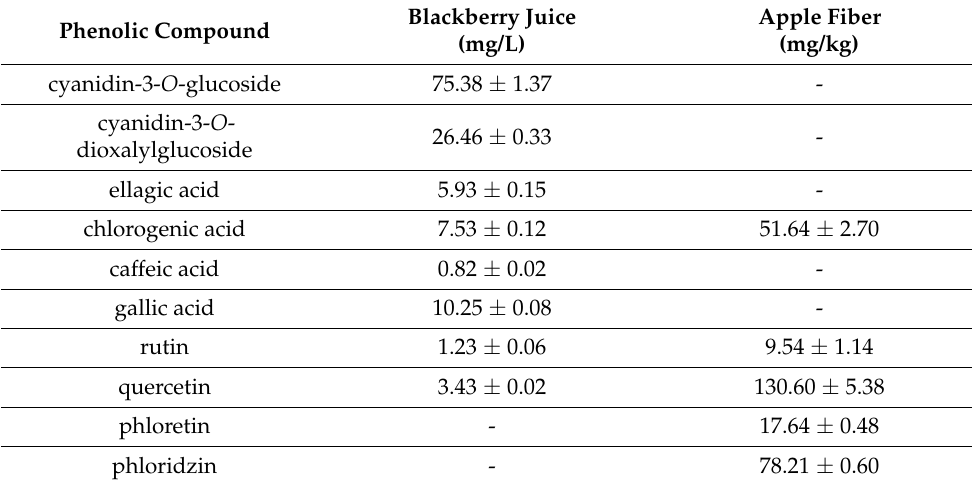
Table 2. Individual phenolic compounds of blackberry juice and apple fiber determined by HPLC analysis.